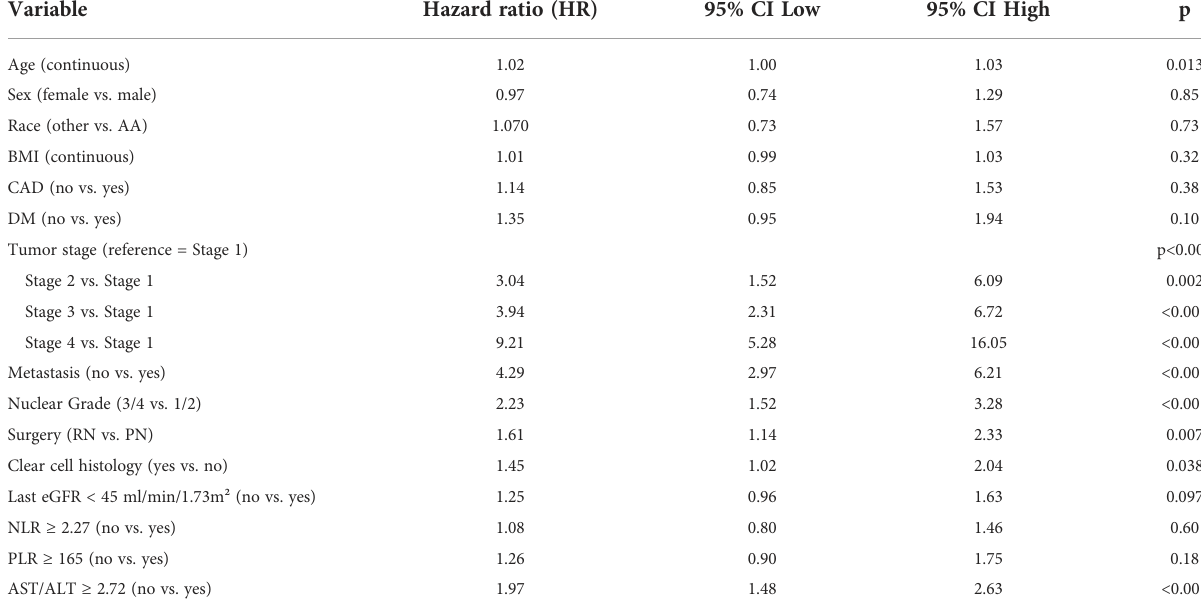
TABLE 2C Multivariable analysis for cancer-speci fi c